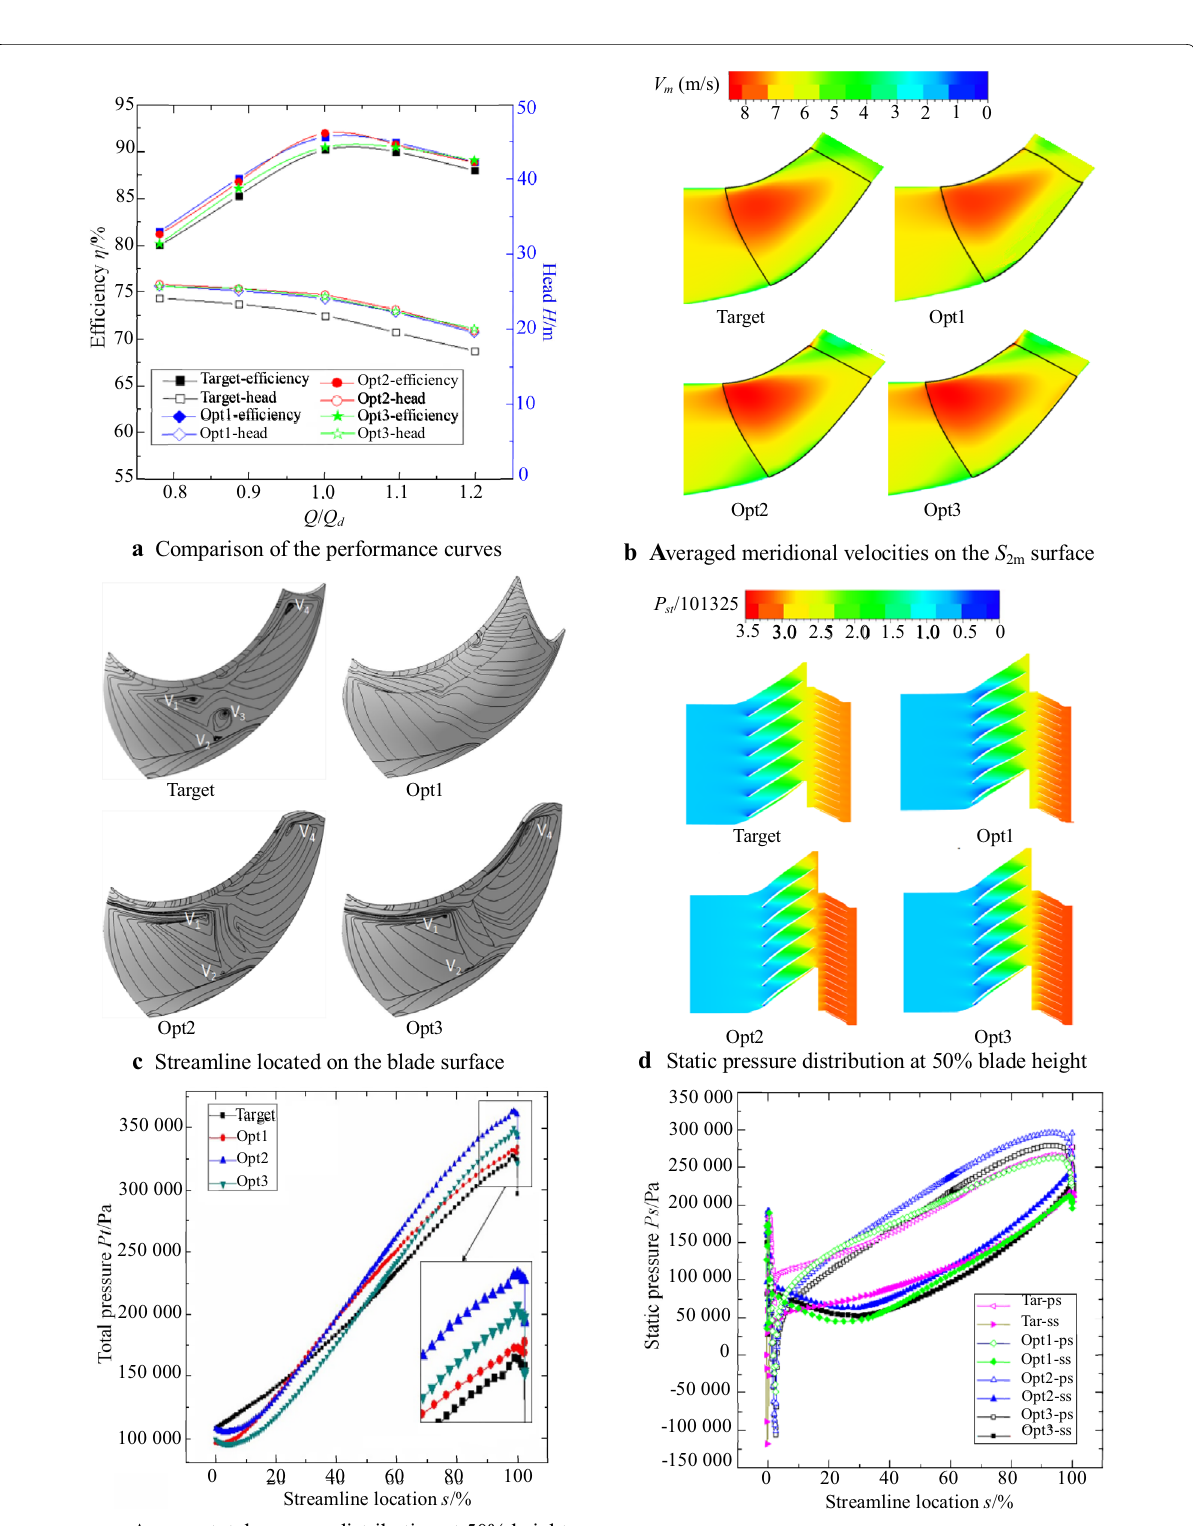
Figure 11 Comparison of the target and the optimal